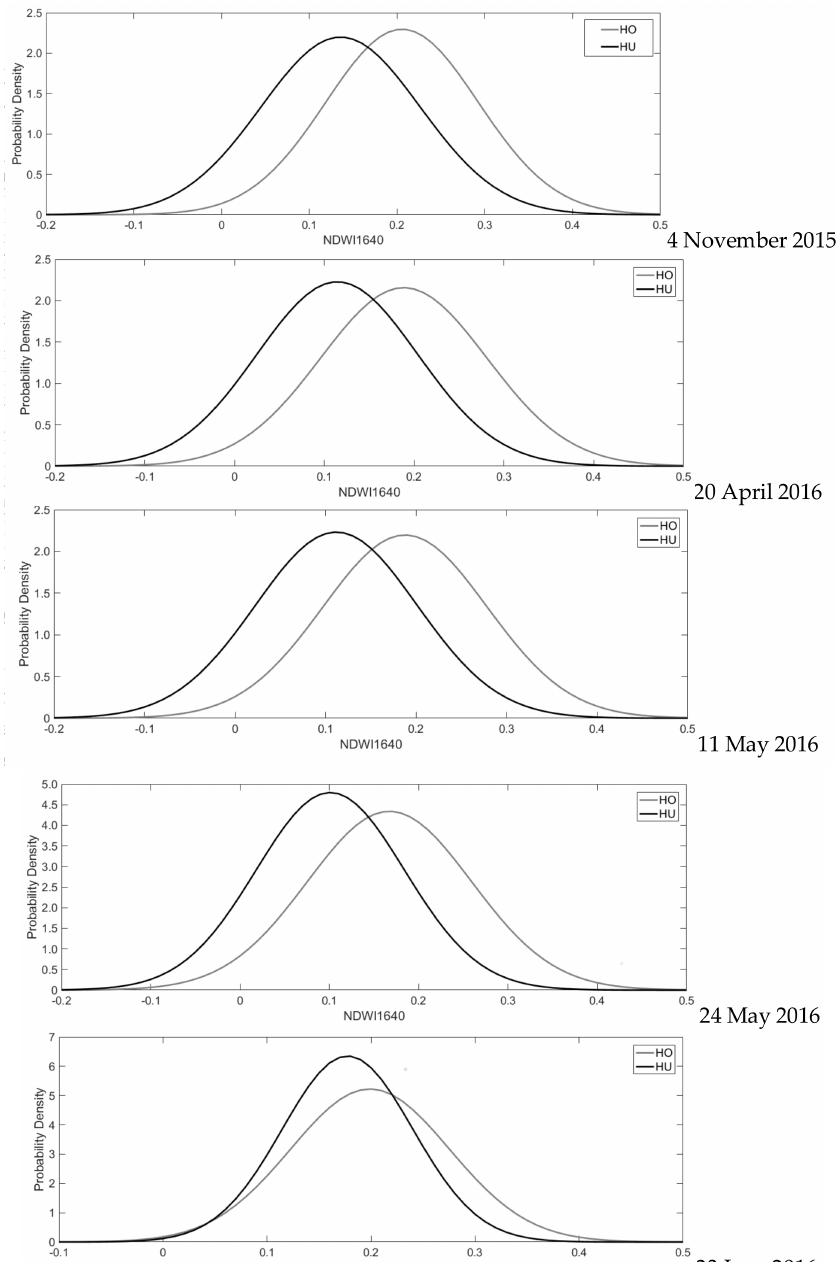
Figure A1. Probability density functions (PDF) comparing hollow (HO) v hummocks (HU) near surface water content based on the NDWI 1640